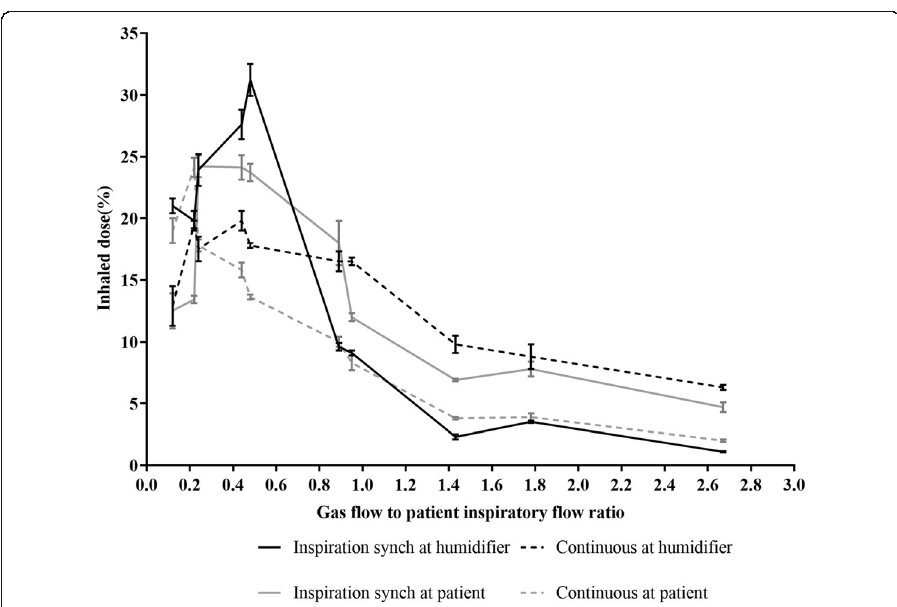
Fig. 3 The relationship between inhaled dose and the gas flow to patient inspiratory flow ratio with inspiration synchronized and continuous